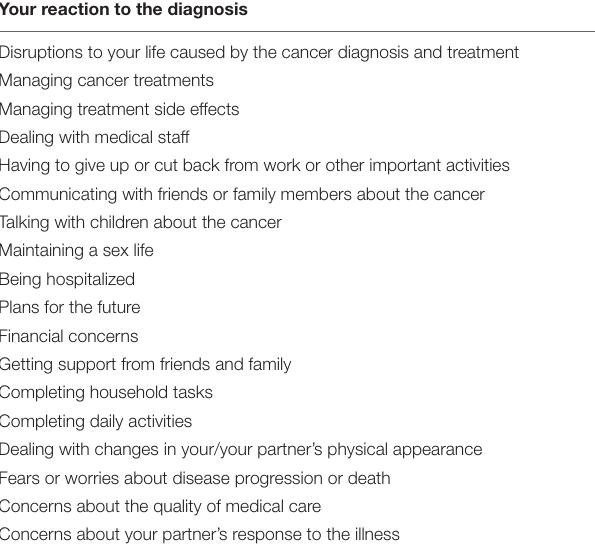
TABLE 3 | Possible discussion topics. TABLE 4 | Key behaviors and affective expressions derived from the ABCS and